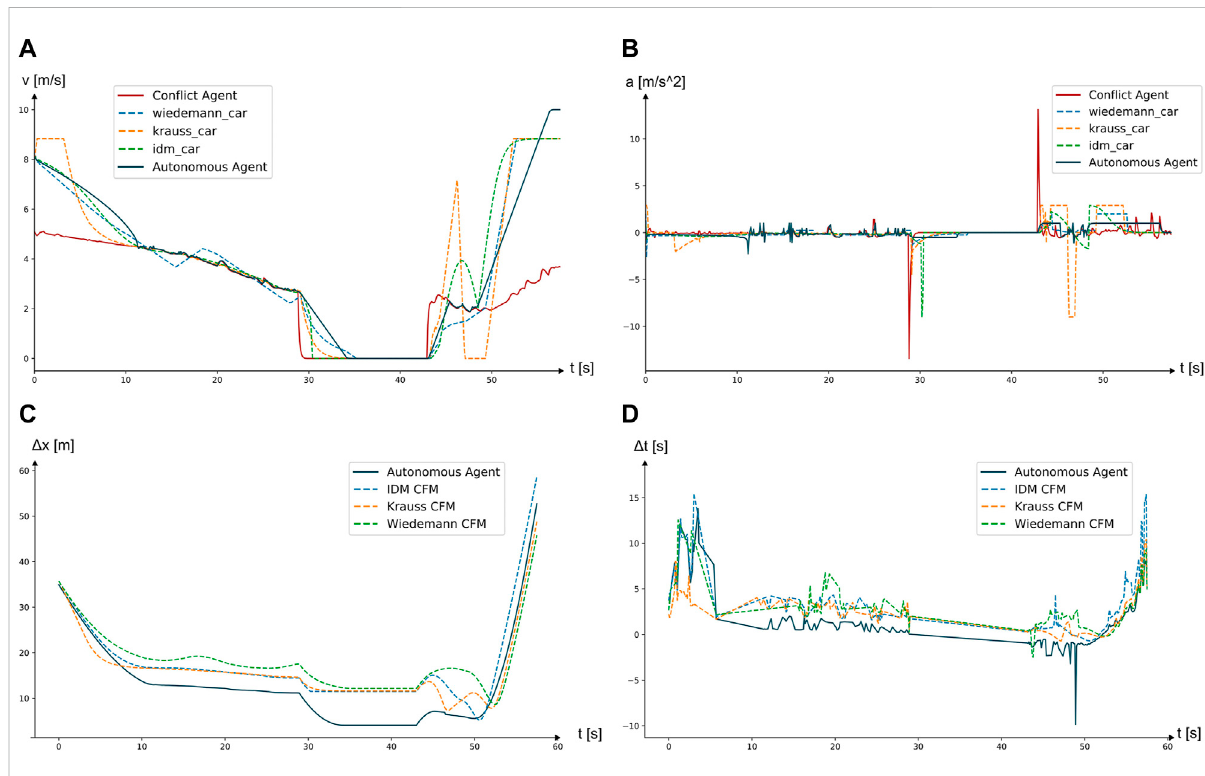
FIGURE 9 (A) Resulting speed pro fi les for scenario 2, (B) resulting acceleration and deceleration pro fi les for scenario 2, (C) showing the distance to the leading agent for scenario 2, (D) showing the difference between the actual TTC and TTC req de fi ned by the given minimum safety distance to the leading agent for scenario